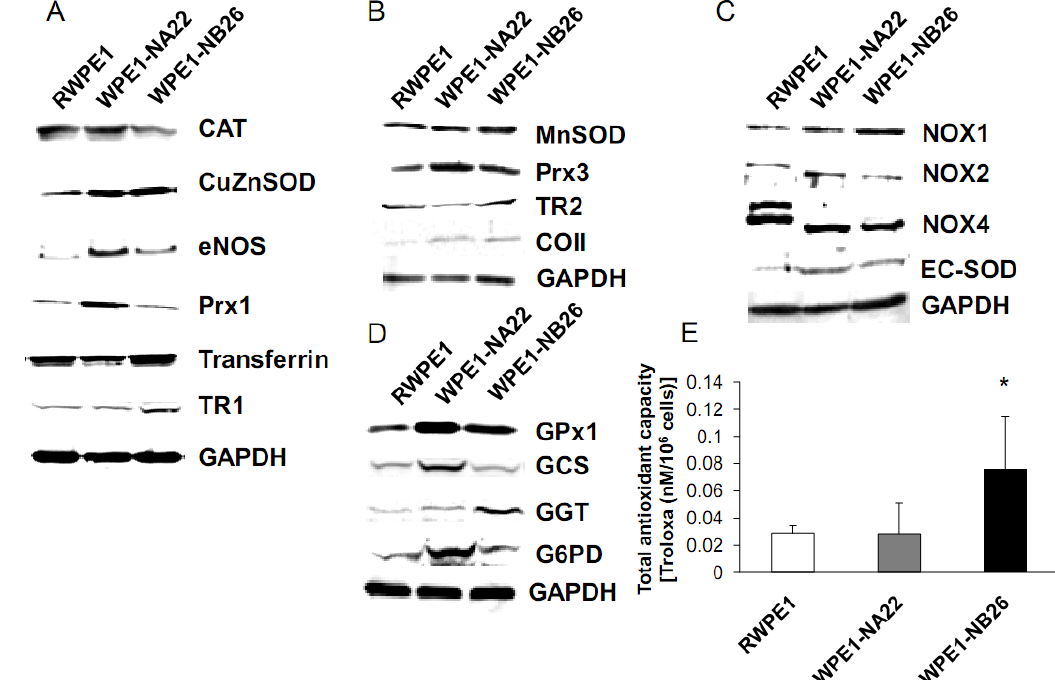
Figure 5. Western blot analysis of redox-related immunoreactive proteins of RWPE1, WPE1-NA22, or WPE1-NB26 cells. Cells were collected during log phase and cell lysates were used for analysis. ( A ) Cytoplasmic redox-related protein expression levels; CAT, CuZnSOD, eNOS, Prx1, TF, and TR1; ( B ) Mitochondrial redox-related protein expression levels; MnSOD, Prx3, TR2, and COII; ( C ) Cell membrane redox-related protein expression levels; NOX1, NOX2, NOX4, and EC-SOD; ( D ) Glutathione-related enzyme protein expression levels; GPx1, GCS, GGT, and G6PD. The figures are representative of three independent experiments; ( E ) Total antioxidant capacity. * P-value ≤ 0.05 when compared with RWPE1